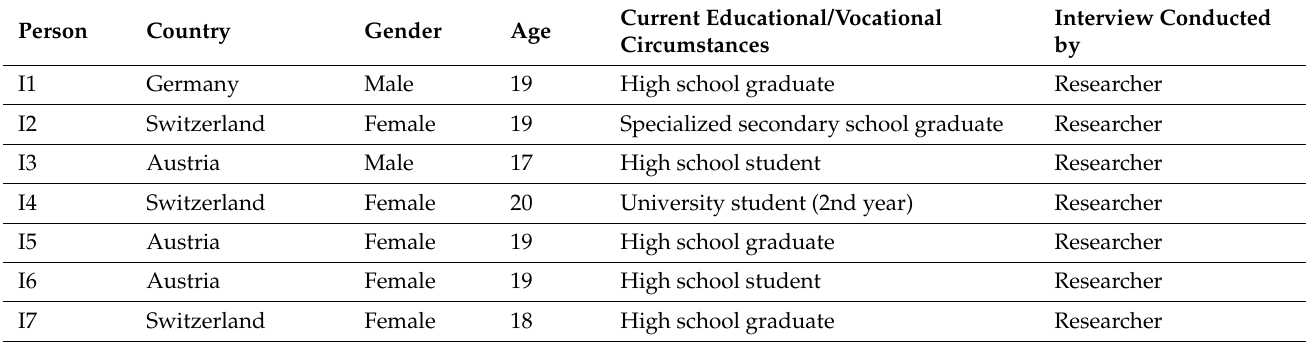
Table 1. Details of the